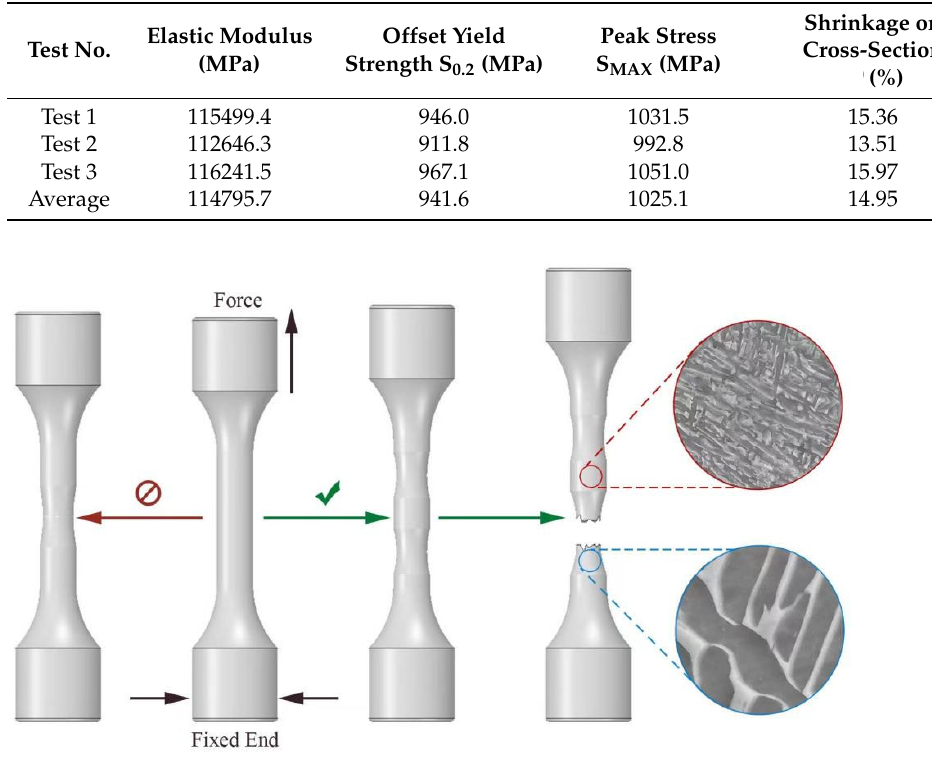
Figure 4. Schematic diagram of tensile test.